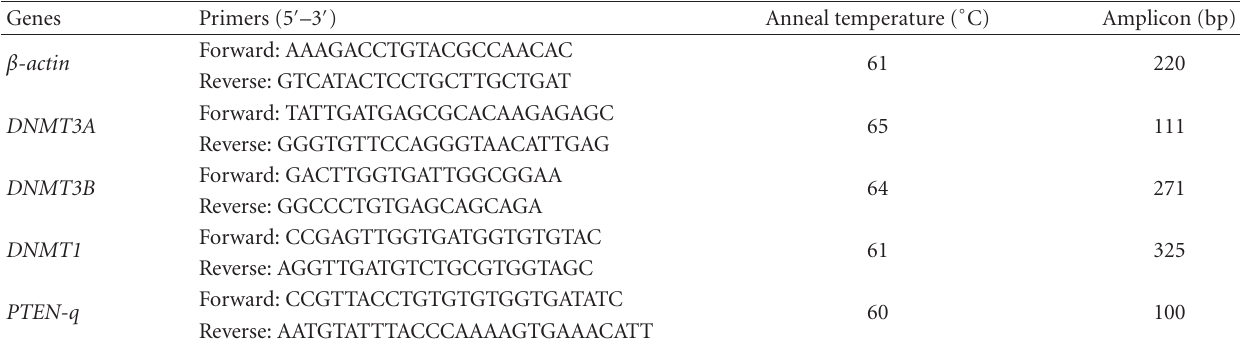
Table 1: Primers sequences and related amplicons for quantitative real-time RT-PCR or RT-PCR.